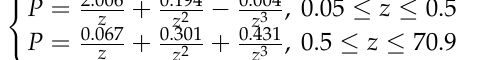
Figure 11. P – z fitting curves in different directions.